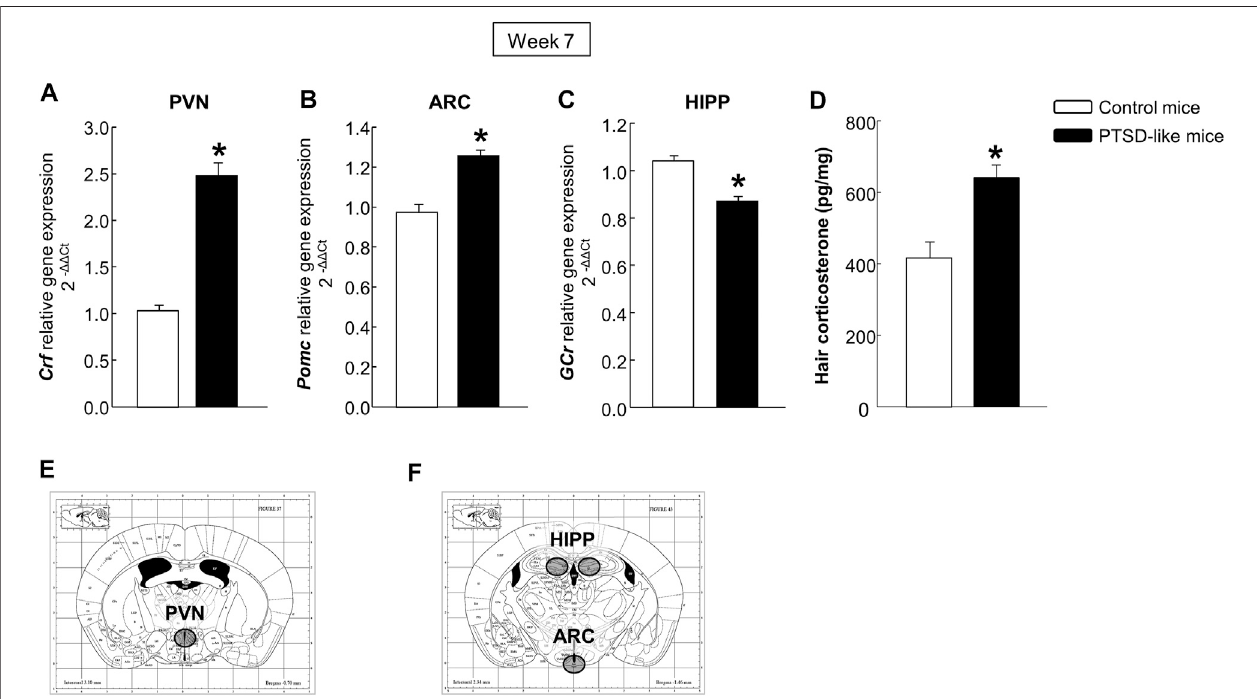
FIGURE 3 | Relative gene expression analyses of corticotropin releasing factor ( Crf ) in the paraventricular nucleus (PVN) (A) , proopiomelanocortin ( Pomc ) in the arcuate nucleus (ARC) (B) , and glucocorticoid receptor ( GCr ) in the hippocampus (HIPP) (C) by real time PCR. Quanti fi cation of hair corticosterone (pg/mg) (D) by Enzyme-Linked ImmunoSorbent Assay (ELISA). Columns represent the mean and vertical lines ± SEM of 2 - ΔΔ C . *, Values from PTSD-like mice that are signi fi cantly differentfromcontrolmice(Student ’ s t -test, p < 0.001).MiceexposedtothePTSD-likemodel:N (cid:2) 8;controlmice:N (cid:2) 8. (E,F) Representativeimagesfrom Paxinos and Franklin ’ s mouse brain atlas including the selected coronal sections to microdissect the regions of interest.